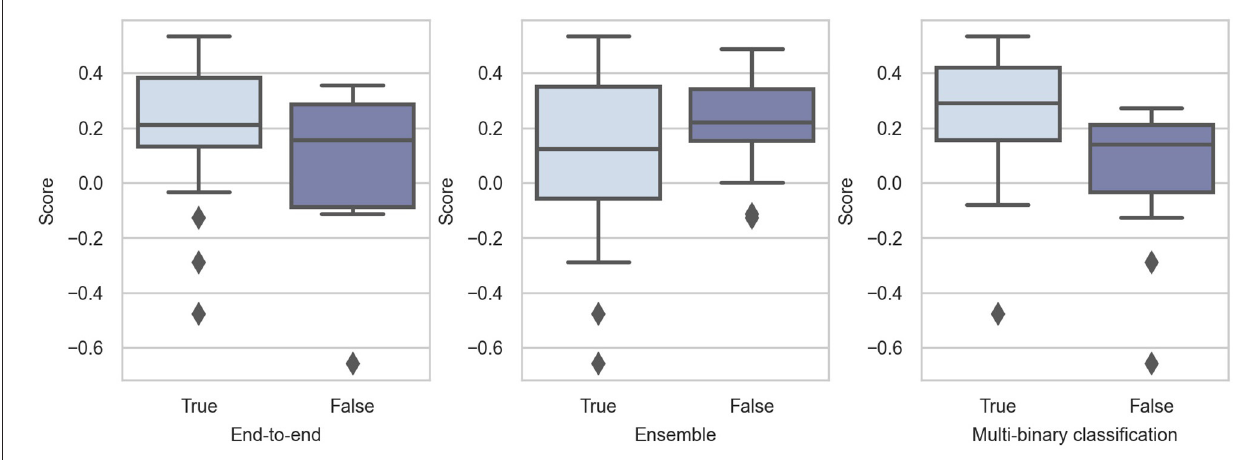
FIGURE 6 | Box-plots of score distributions of training strategy